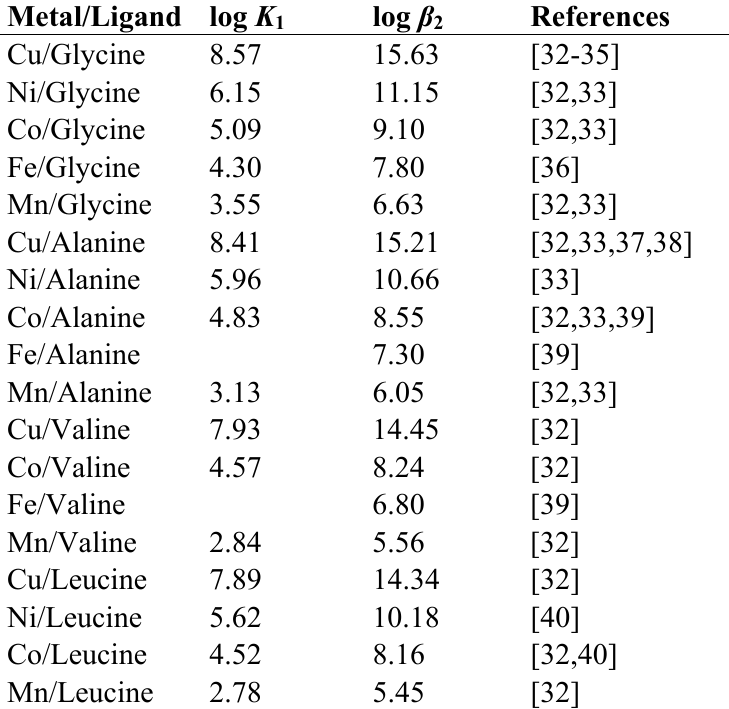
Table 1. Experimental stability constants for metal(II) chelates with α -amino